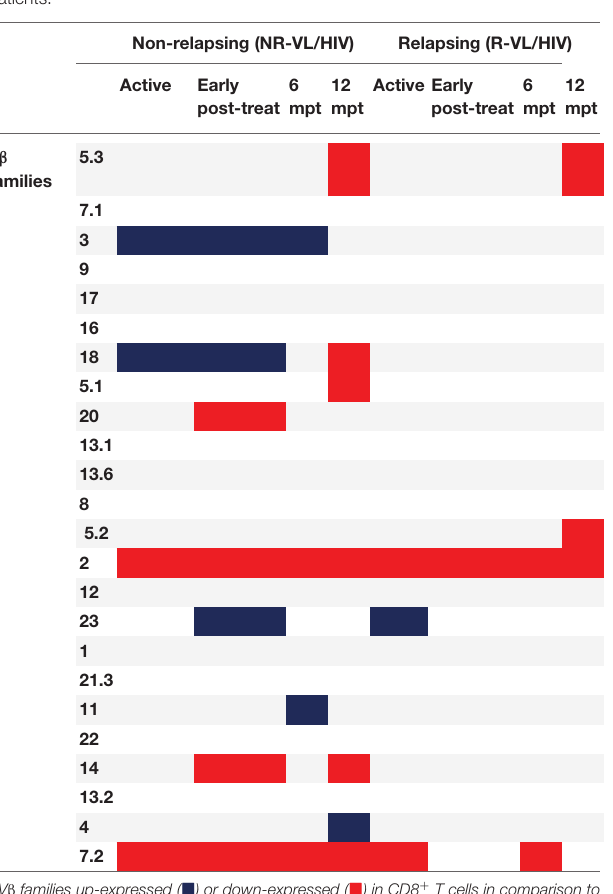
TABLE 3 | Differences in the CD8 + T-cell V β repertoire mobilization profile of non-relapsing and relapsing visceral leishmaniasis/HIV (VL/HIV) co-infected